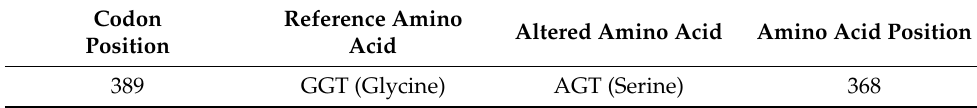
Table 7. Non-synonymous mutation of the mexA gene.